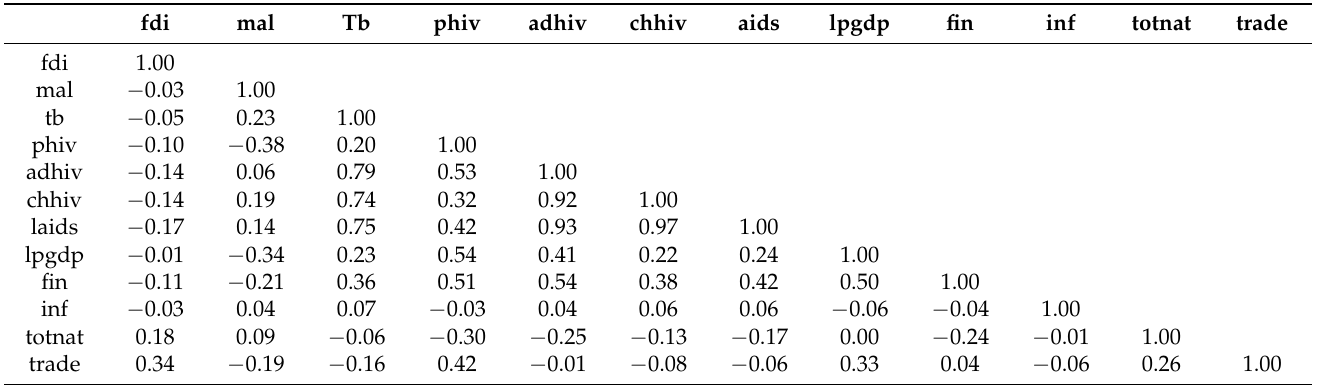
Table 3. Correlation